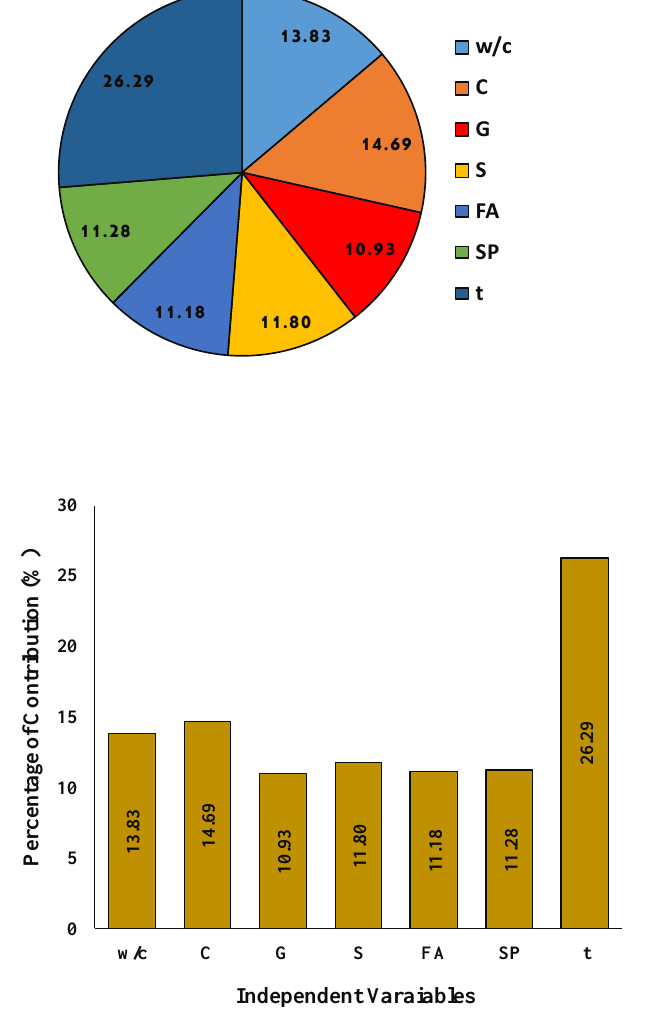
Figure 12. Sensitivity analysis to investigate the effect of input variables on the CS of CSS using the ANN model.